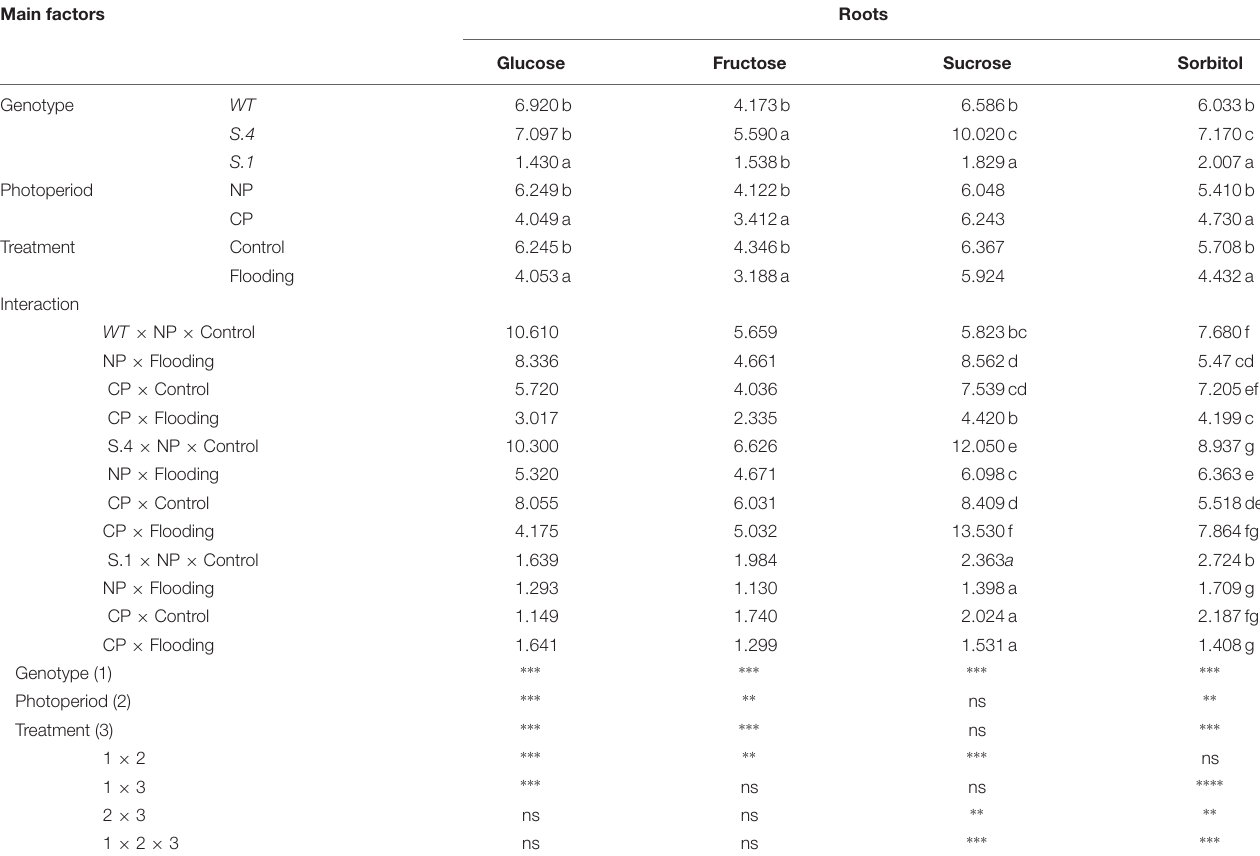
TABLE 3 | (B) Carbohydrates detected in roots (b) of S.1 , S.4, and WT plants, exposed to natural photoperiod (NP) and constant photoperiod (CP) after 14 days of flooding. Main